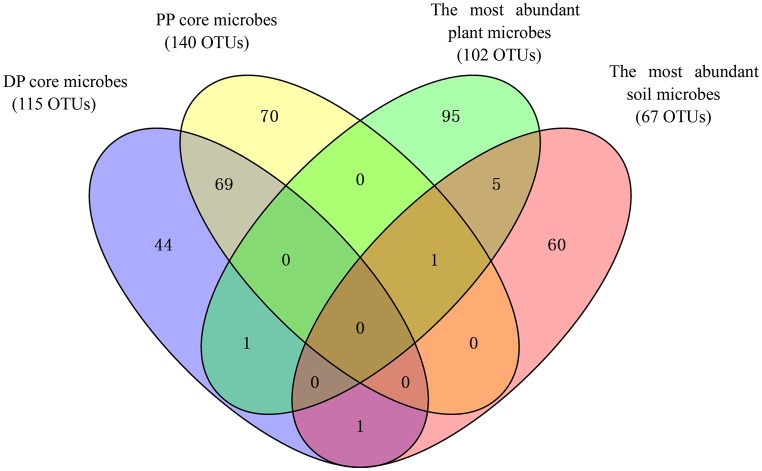
Venn diagram showing the overlap between pika (DP, Daurian pikas; PP, Plateau pikas) core microbes and the most abundant environmental microbes (> 0.1% relative abundance).